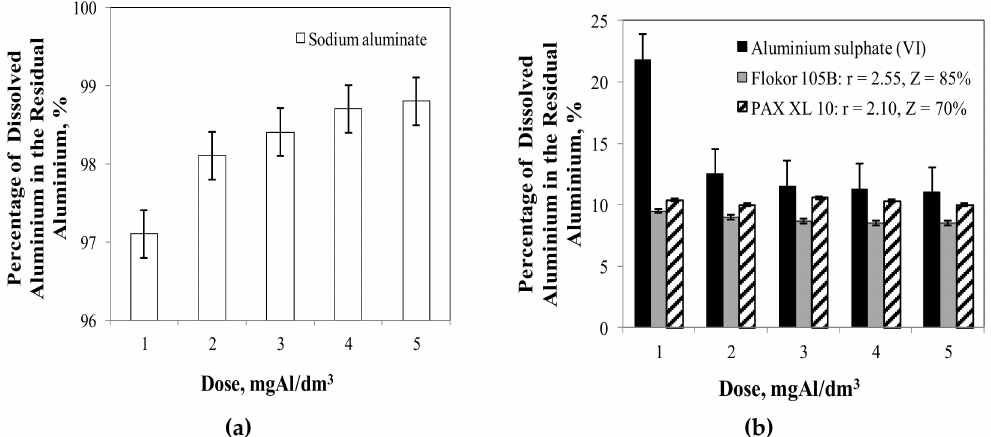
Figure 5. E ff ect of the dose of aluminium sulphate (VI), PAX XL 10 and Flokor 105B ( a ) and sodium aluminate ( b ) on the content of aluminium dissolved in the total residual aluminium in purified